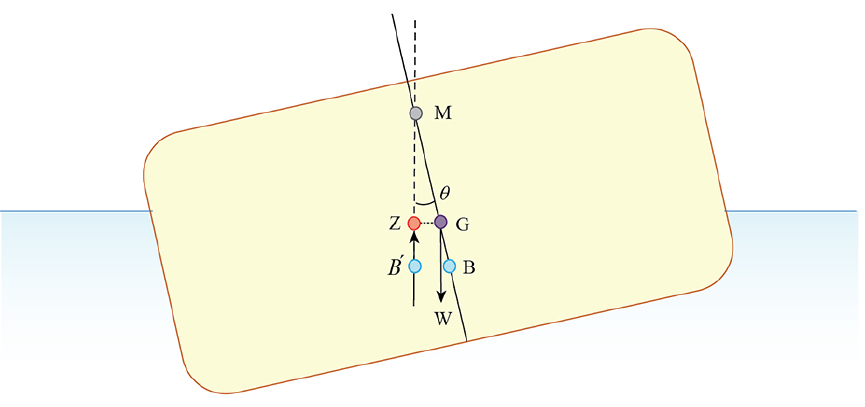
Figure 1. Ship inclined at an angle θ .